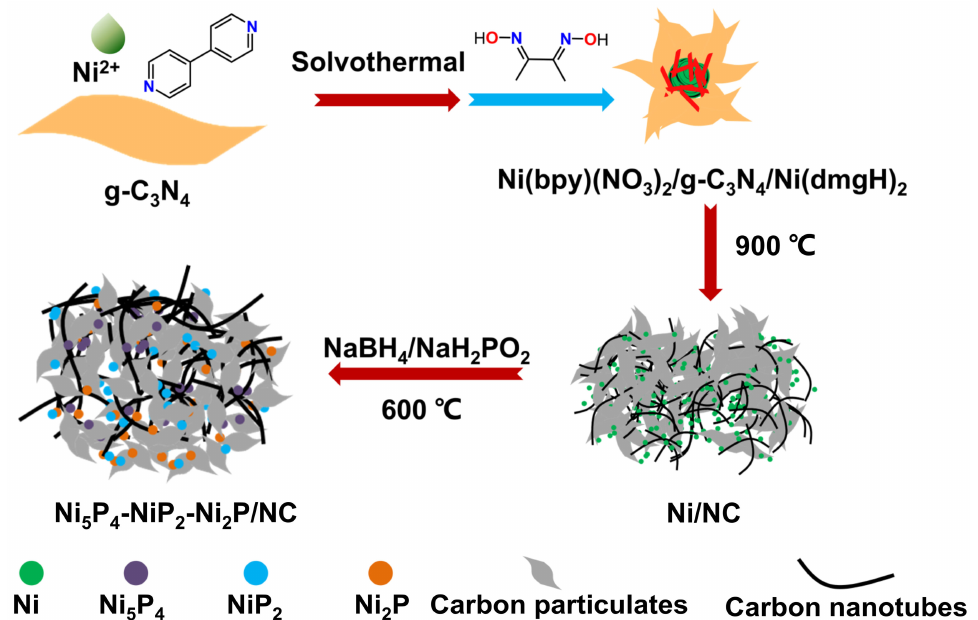
Figure 1. Illustration drawing of the synthesis process of Ni 5 P 4 -NiP 2 -Ni 2